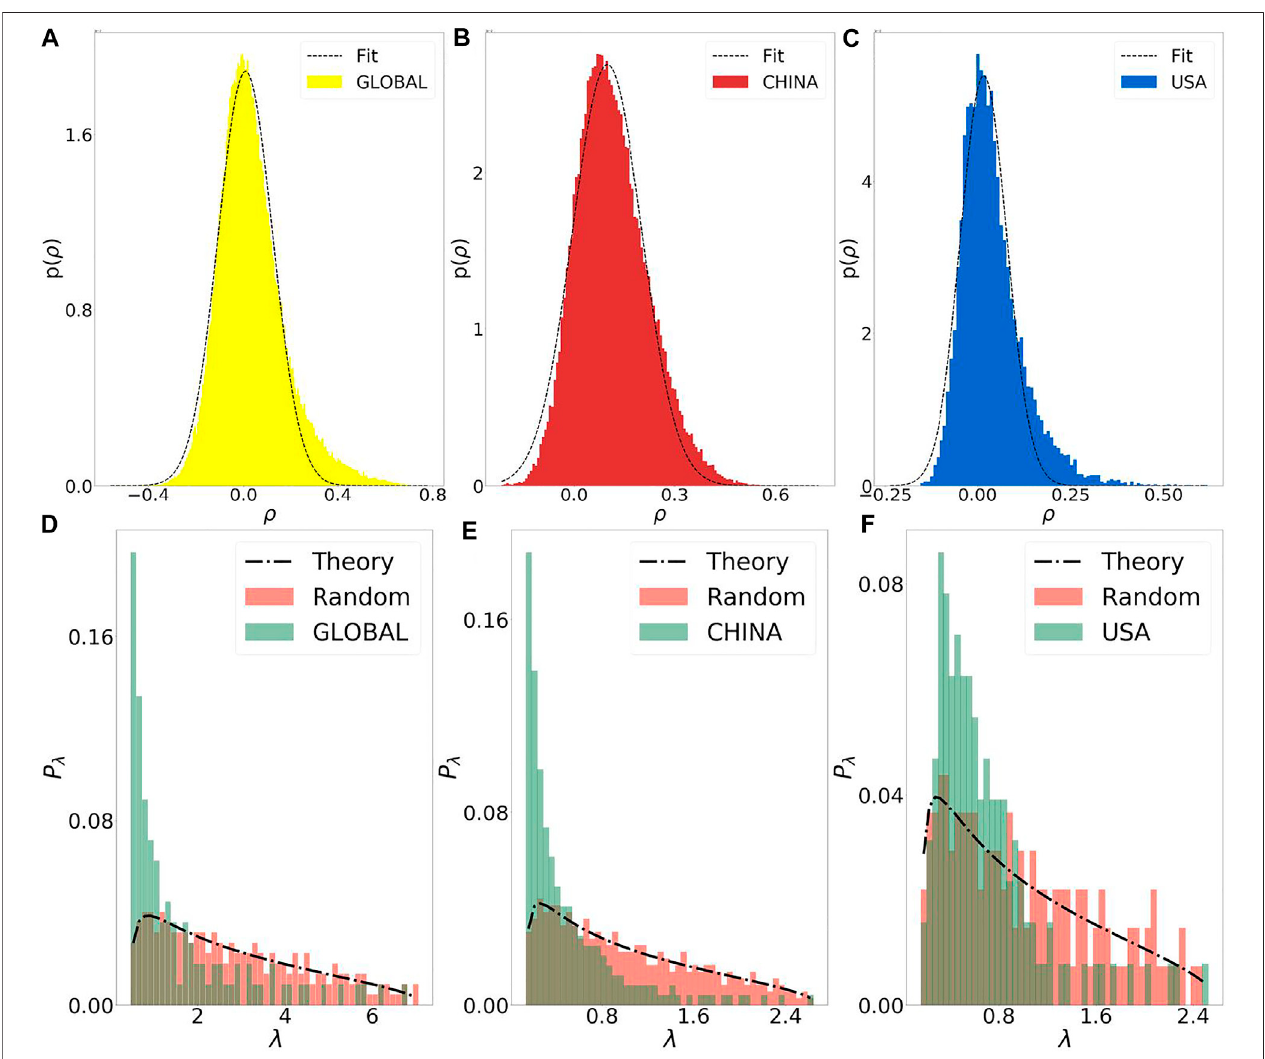
FIGURE 2 | The statistical properties of the cross correlation matrix C for the PM 2 . 5 time series. (A) presents the distributions of ρ ( τ (cid:2) 0) for the global data, (B) presents the distributions for the Chinese data, and (C) presents the distributions for the American data, respectively. In (D – F) , the green and red bars represent the probability distributions of the eigenvalues from the real data and the random series, respectively. The black dashed-dotted line is the theoretical result of Eq. 4 .